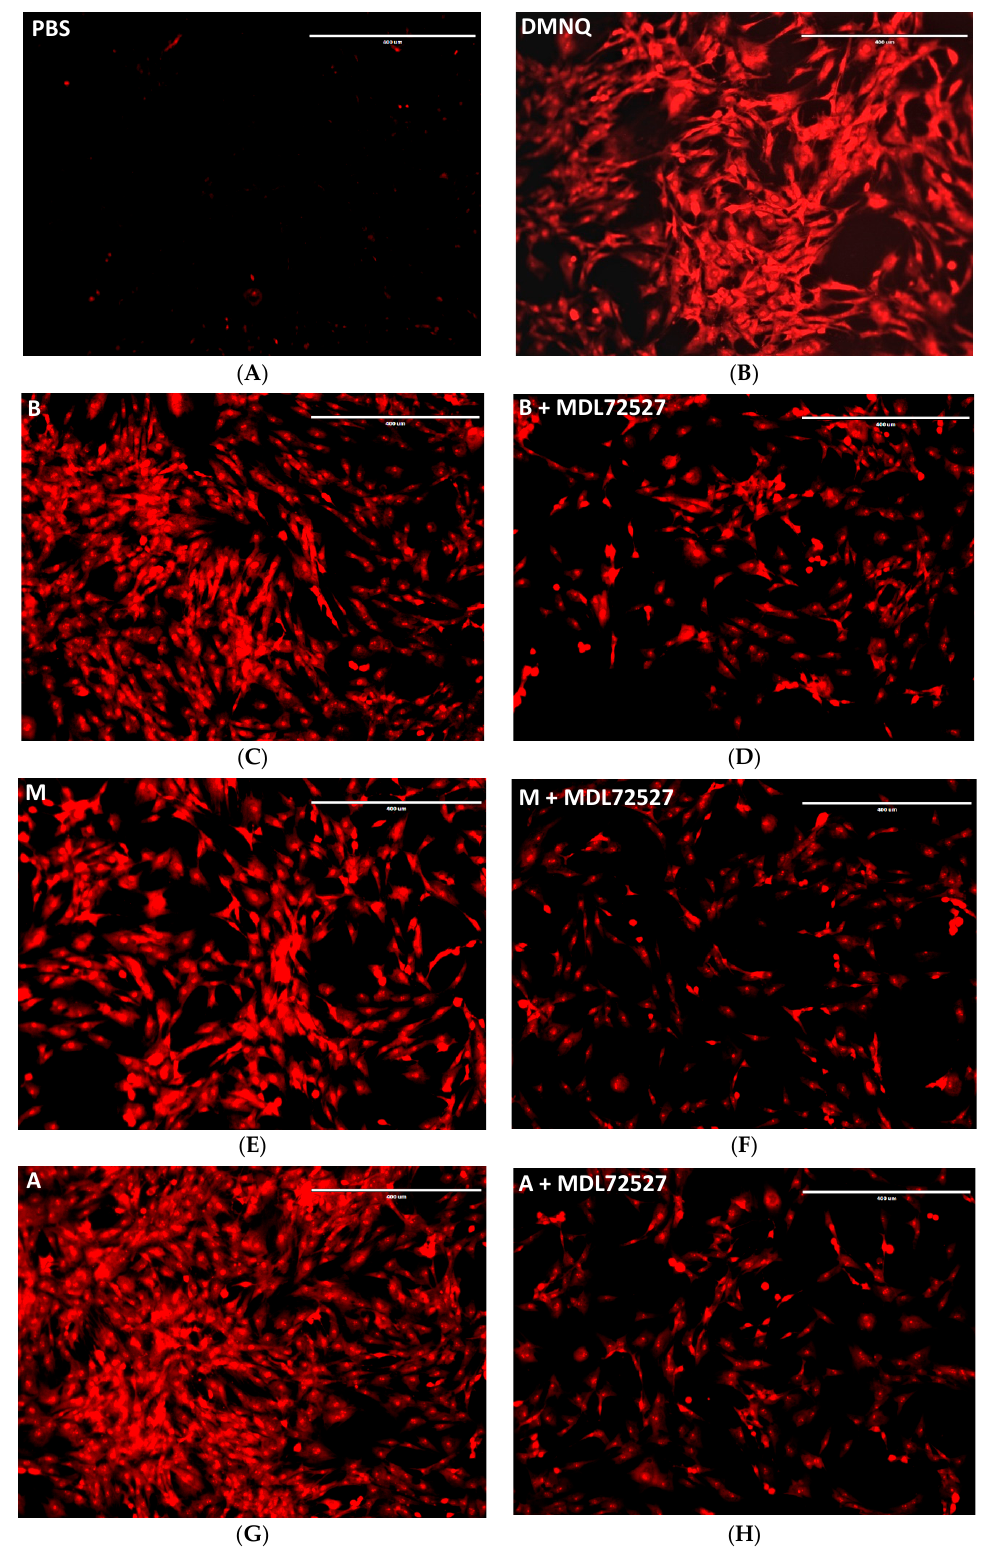
Figure 6. Fluorescent images depicting ROS production in: cells treated with 1 × PBS (( A ), negative control), 5 µ M DMNQ (( B ), positive control), 500 µ M benzylamine ( C ), 500 µ M benzylamine + 100 µ